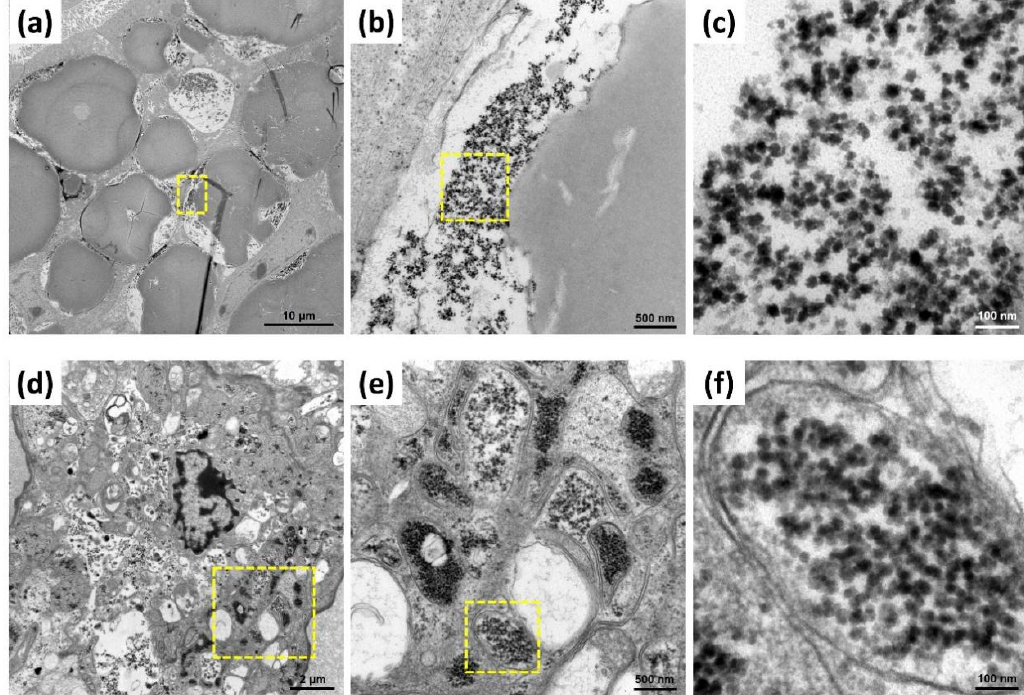
Figure 4. Transmission electron microscope (TEM) micrographs of hepatopancreas and gill ultrathin section of Macrobrachium rosenbergii naturally infected with covert mortality nodavirus (CMNV). ( a –